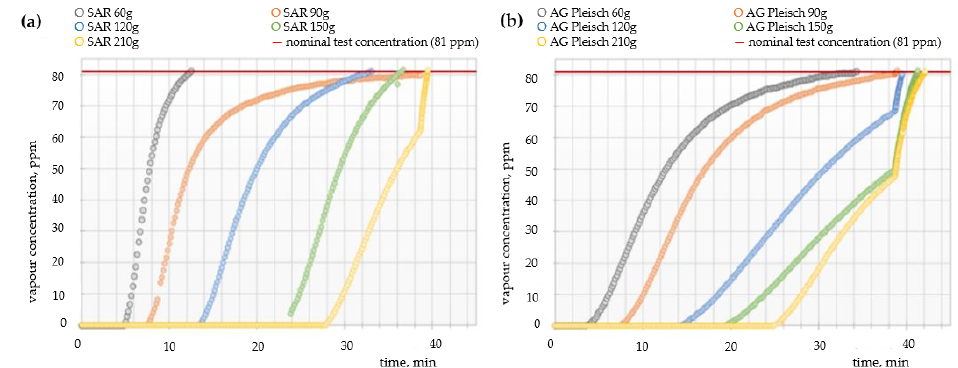
Figure 4. Breakthrough time curves of cyclohexane vapors for filtration fabrics with different con- tents of ( a ) SAR and ( b ) AG Pleisch sorbents.